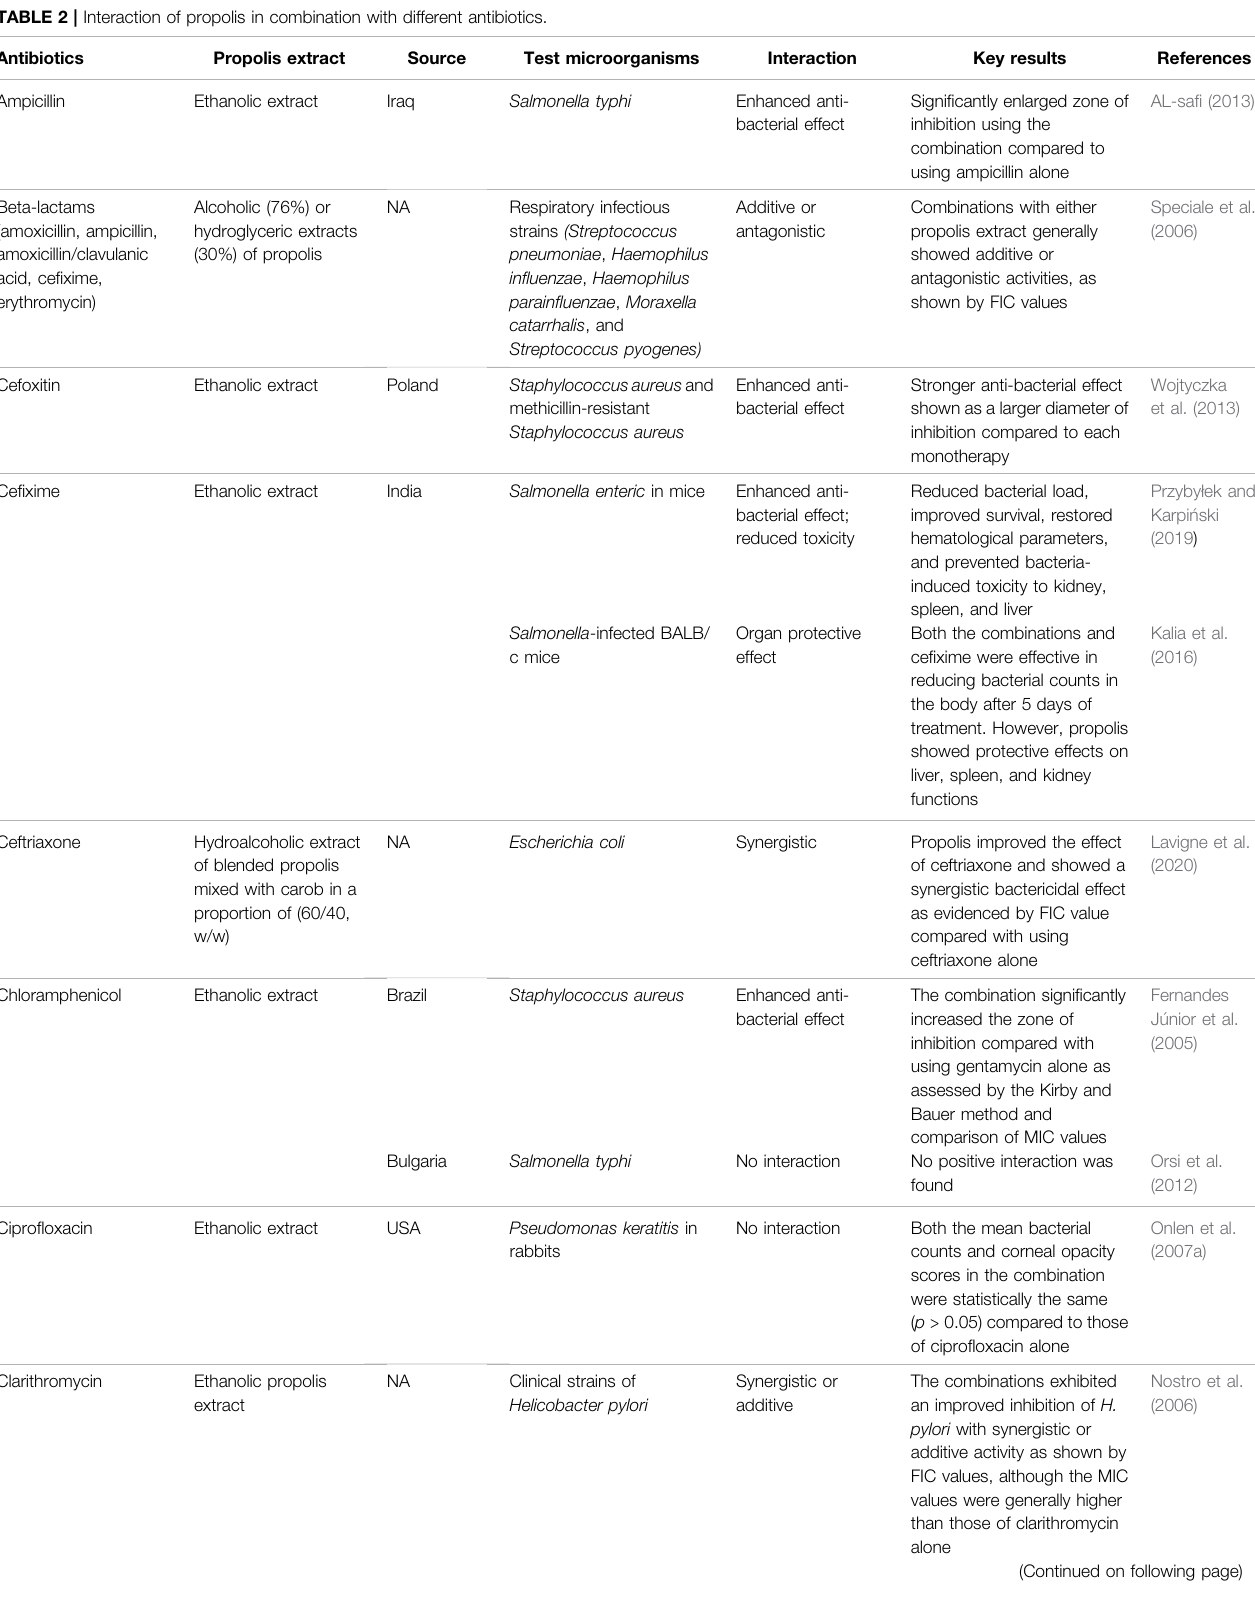
TABLE 2 | Interaction of propolis in combination with different